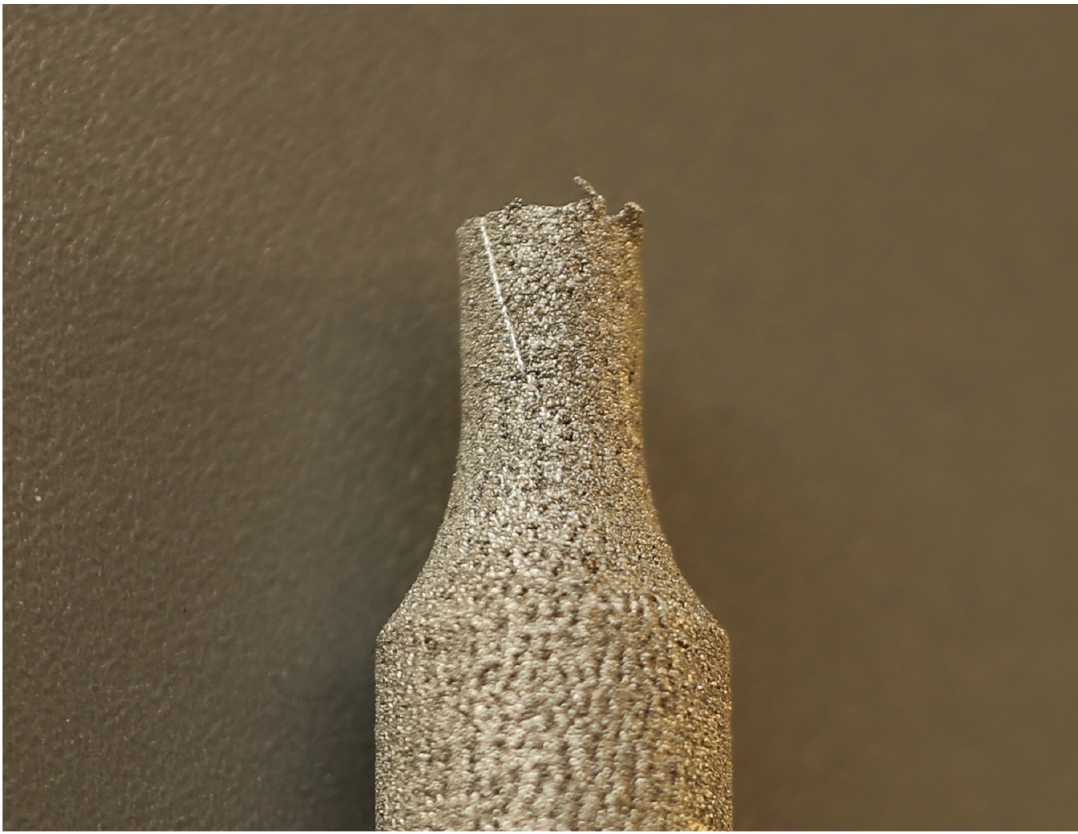
Figure 2. Specimen after the torsional test. Marked line, parallel to the specimen axis before test is inclined to specimen axis. Angle between axis and marked line is shear angle.